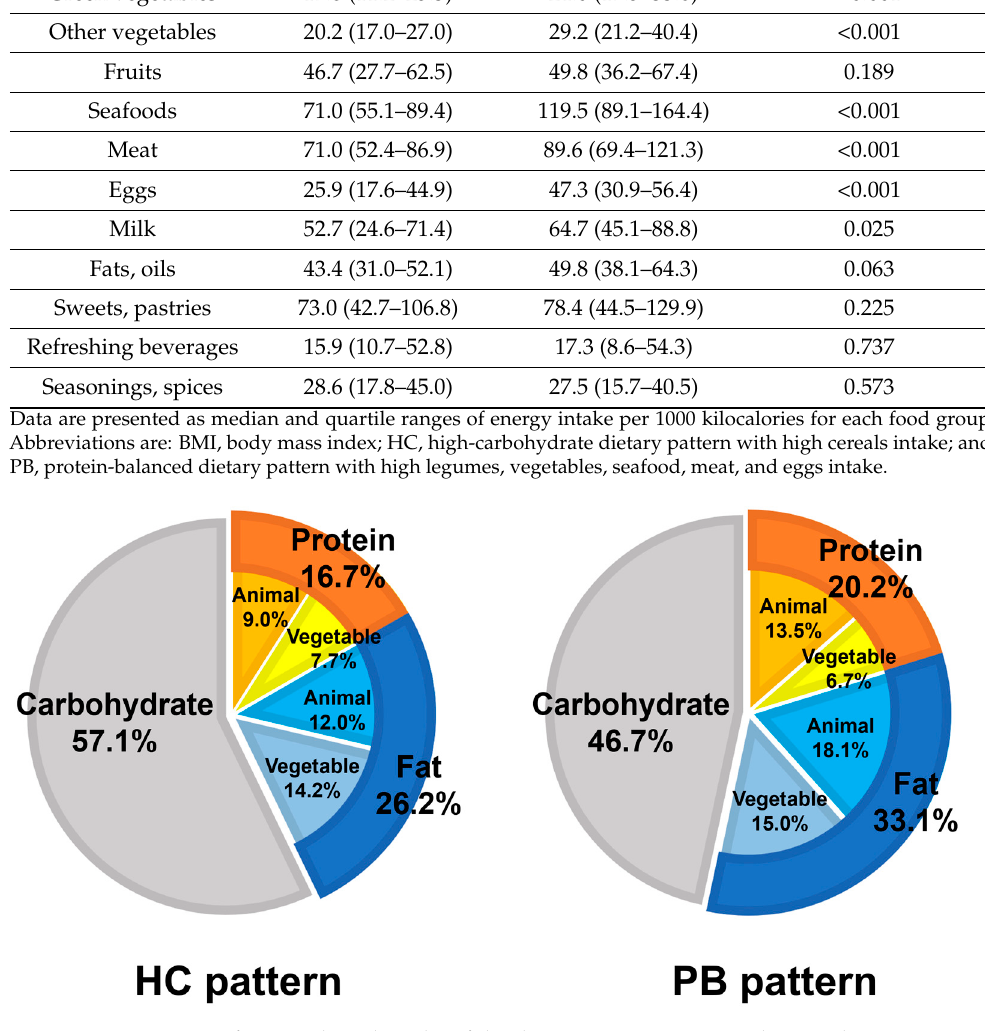
Figure 2. Percentage of energy-based intake of the three macronutrients in the two dietary patterns classified by discriminant analysis model. Data are presented as median values.